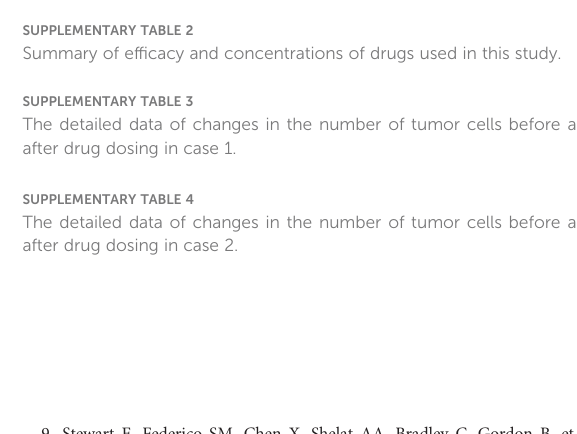
SUPPLEMENTARY TABLE 2 Summary of ef fi cacy and concentrations of drugs used in this study. SUPPLEMENTARY TABLE 3 The detailed data of changes in the number of tumor cells before and after drug dosing in case 1.